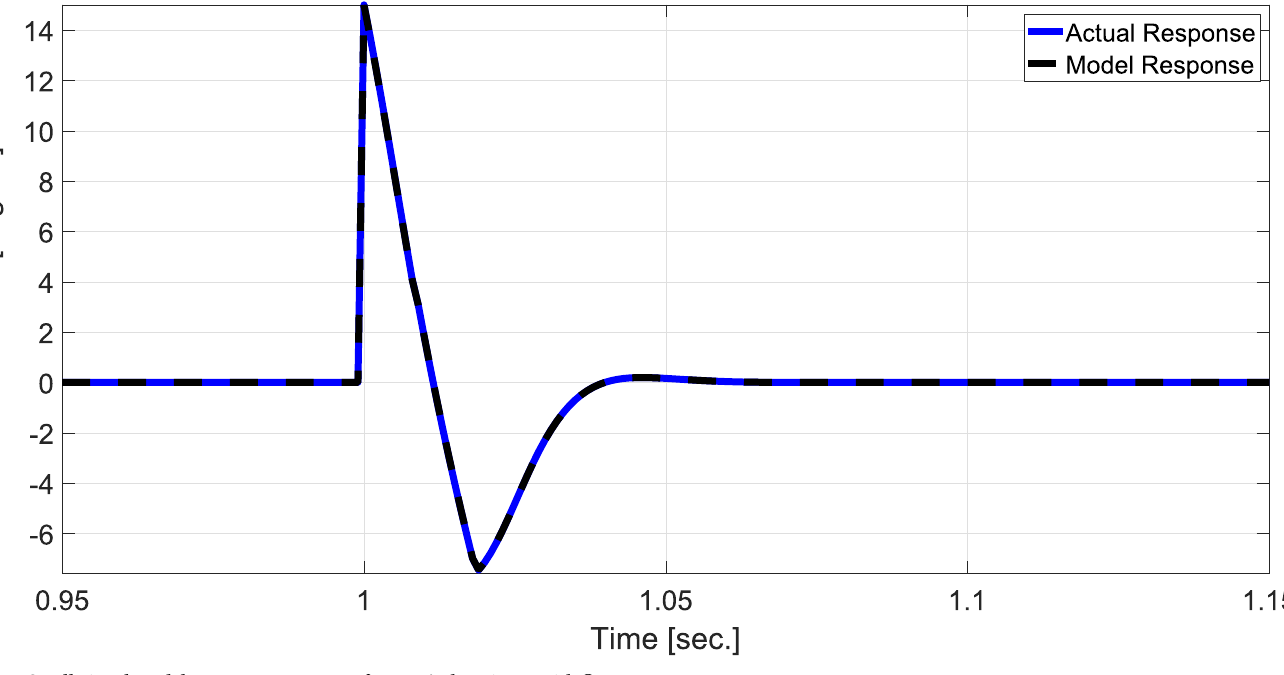
Fig 3. Small-signal model accuracy assessment for + 15˚ phase jump with O =